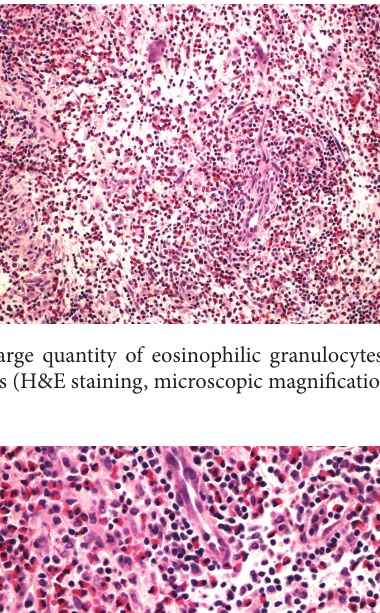
potassium level of 5.04 mmol/ L (norms are 3.6–5),